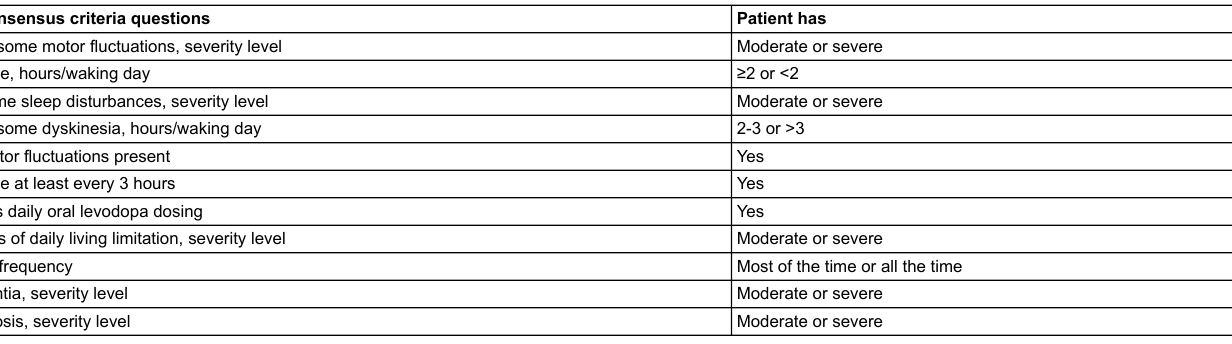
Table 1: Delphi criteria for advanced Parkinson’s disease (APD)